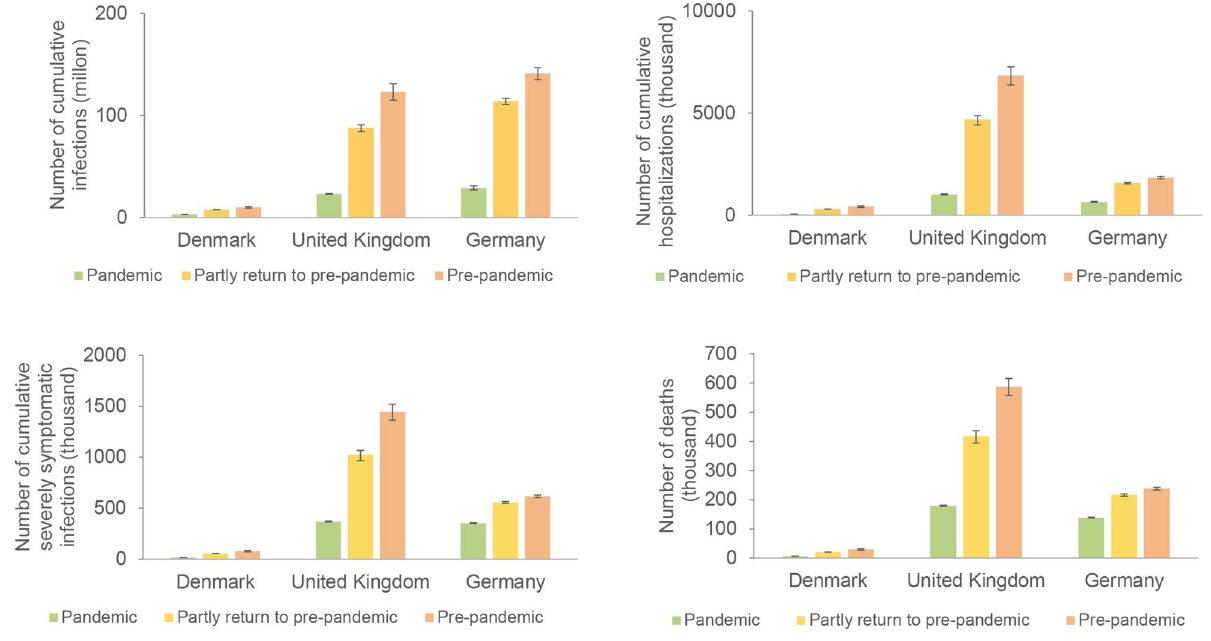
Figure 3. Burden of COVID-19 under different levels of social activity. The simulated cumulative number of infections includes both asymptomatic carriers and symptomatic patients. The level of social activity is expressed in terms of social contacts, which are estimated according to the average number of human social contacts to a person and assuming a homologous secondary attack rate. The pandemic social activities scenario matched the epidemiological characterization in Week 12, 2022 (the reproduction number is around 0.9). The scenario of partially returning to pre-pandemic social activities refers to the number of close contacts reported in technical briefing of SARS-CoV-2 variants identified by UK Health Security Agency from January to February in 2022 (the reproduction number is around 1.5). The scenario of resuming pre-pandemic social activities is set in accordance with mixing patterns in social networks before the COVID-19 pandemic. ( Source https:// doi. org/ 10. 1016/j. socnet. 2007. 04. 005). The Error lines represent the 95% confidence interval related to